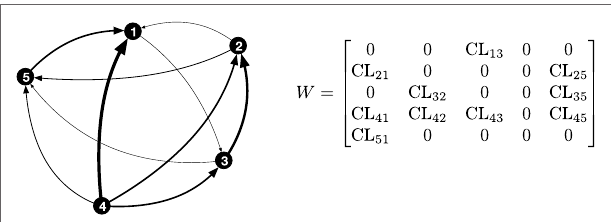
FIGURE 1 | Illustration of pairwise directed interactions between five agents. In a pairwise interaction between two nodes, the edges start from the leader and terminate at the follower, and the weight of the edge, shown as lines of different thickness, is measured by the value of the classifier. The corresponding directed adjacency matrix W is also shown. Based on this, in the network shown above, node 4 acts as leader for the entire